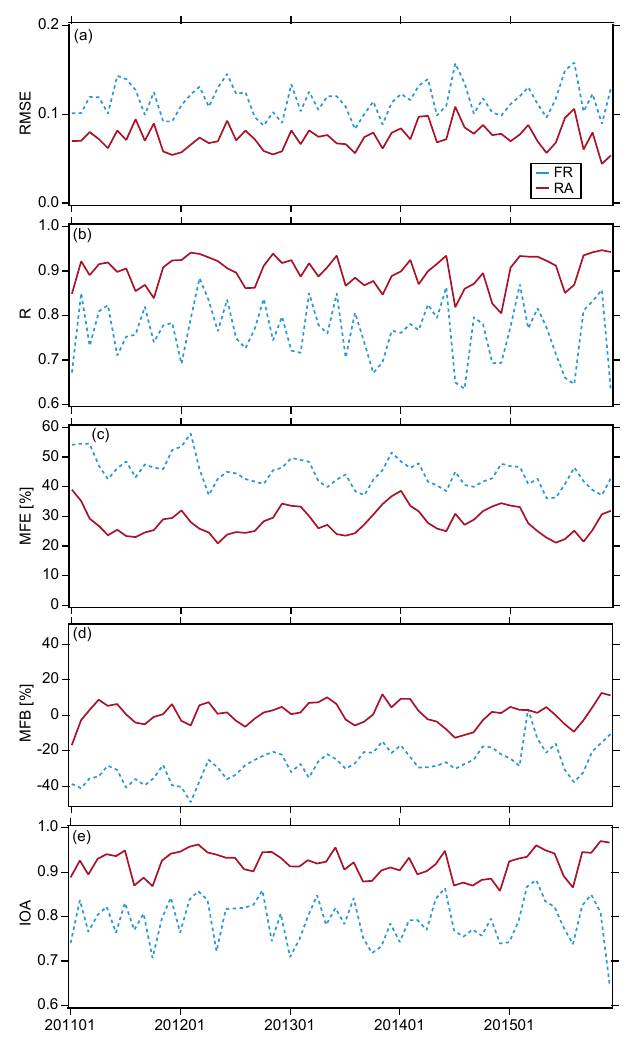
Figure 15. Time series of (a) RMSE, (b) R , (c) MFE, (d) MFB, and (e) IOA for FR (blue) and RA (red), validated by monthly averaged AERONET AODs. The number of AERONET sites used at each time point for these calculations is shown by the thick black line in Fig.